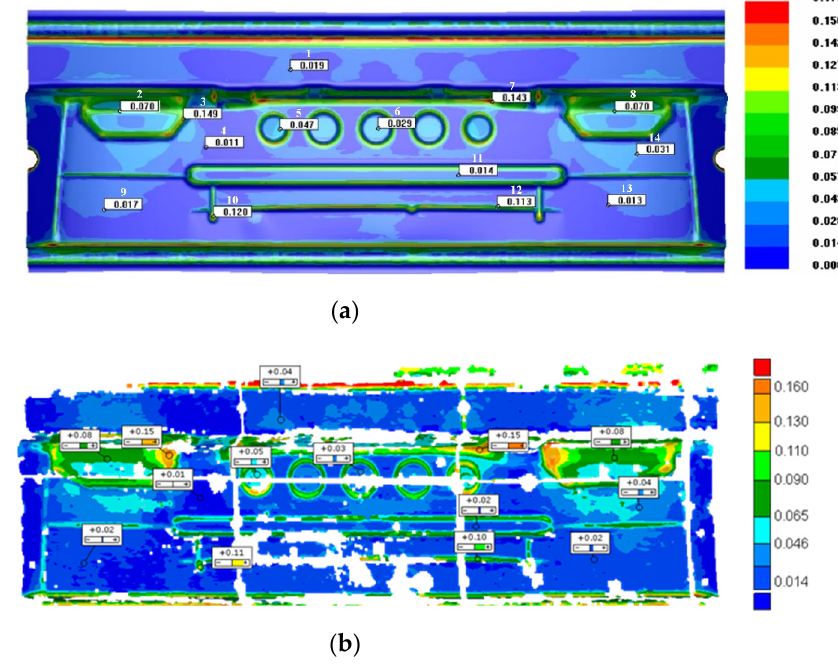
Figure 15. Results of the major strain obtained by ( a ) simulation and ( b ) experiment.